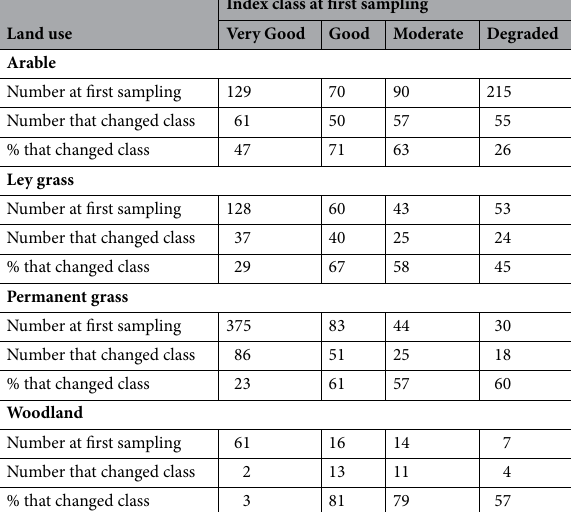
Table 3. Changes in index class between the two NSI samplings by land use and first sampling index class. Note the Very Good class could only move to a lower class and the Degraded class to a higher one, but the Good and Moderate classes could move either up or